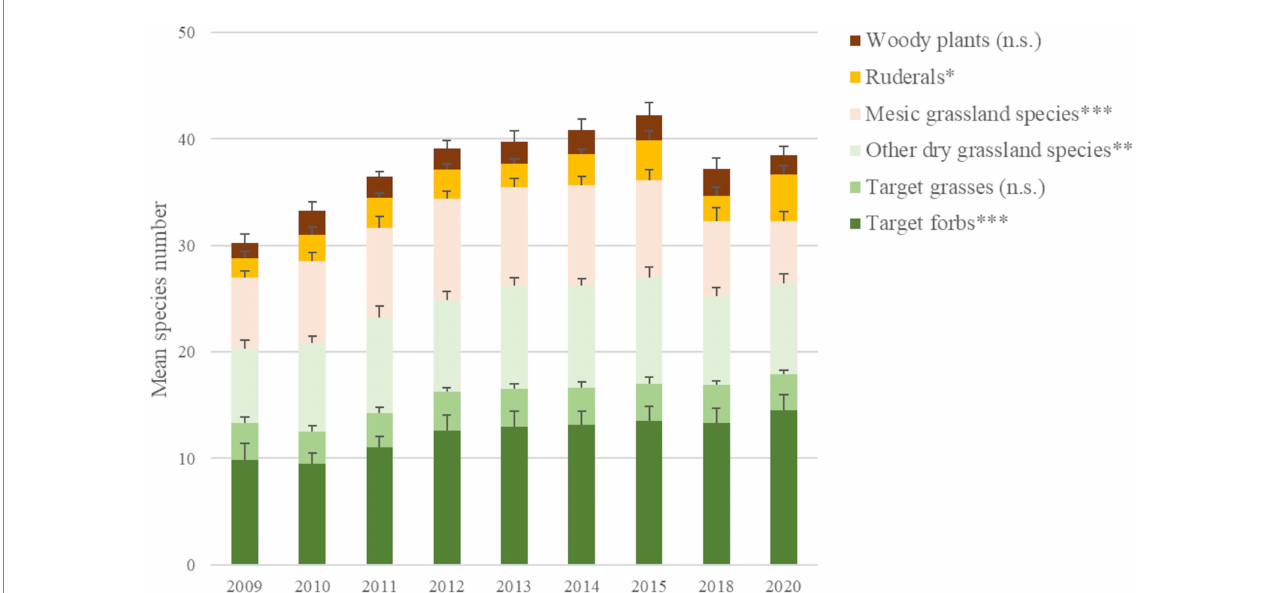
FIGURE 2 Mean vascular plant species number on grazed vegetation survey plots (5 m × 5 m, n = 8). Significant changes in ecological groups over 9 observational years (2009 to 2015, 2018, 2020) are marked with asterisks (n.s. not significant, * p < 0.05, ** p < 0.01, *** p < 0.001; Friedman tests: Target forbs: df = 8; Qui- square = 37.479; p < 0.001; target grasses: df = 8; Qui-s. = 5.539; p = 0.699; other dry grassland species: df = 8; Qui-s. = 25.071; p = 0.002; mesic grassland species: df = 8; Qui-s. = 31.212; p < 0.001; ruderals: df = 8; Qui-s. = 15.550; p = 0.049; woody plants: df = 8; Qui-s. = 11.250; p = 0.188). Error bars indicate